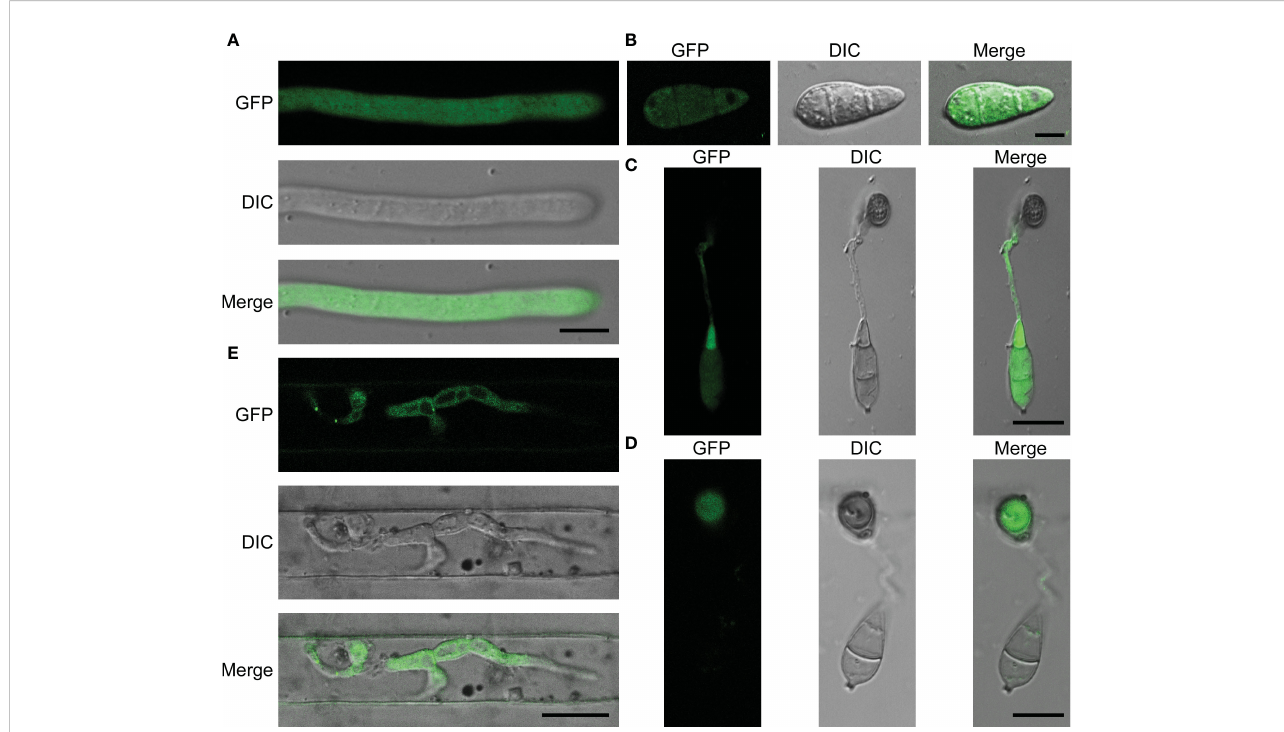
FIGURE 8 MoPdx1 is located in the cytoplasm of M. oryzae. (A) Hyphal blocks of complementary strains were cultured in liquid CM media at 28°C for 18 h, washed two times with sterile water, and single mycelium were photographed under a confocal fl uorescence microscope (Zeiss LSM710, 63x oil). Bar=18 m m. (B) Conidia of complementary strains were observed under a confocal fl uorescence microscope (Zeiss LSM710, 63x oil). Bar=18 m m. (C, D) Appressorium formation was observed under a confocal fl uorescence microscope (Zeiss LSM710, 63x oil) at 14 and 24 hpi. Bar=18 m m. (E) Conidial suspensions (5×10 4 spores/mL) of the complementary strains were collected and inoculated into 21-d rice sheath cells, and the green fl uorescence of IH were observed at 24 hpi under a confocal fl uorescence microscope (Zeiss LSM710, 63x oil). Bar=18 m m.